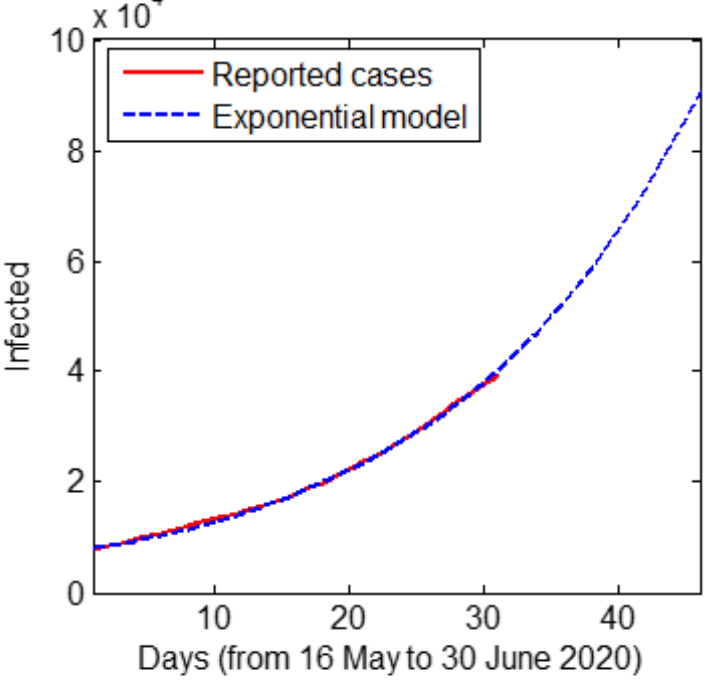
Figure 4. The total coronavirus disease cases in the four considered districts of Tamil Nadu predicted using the updated exponential model and the actual reported